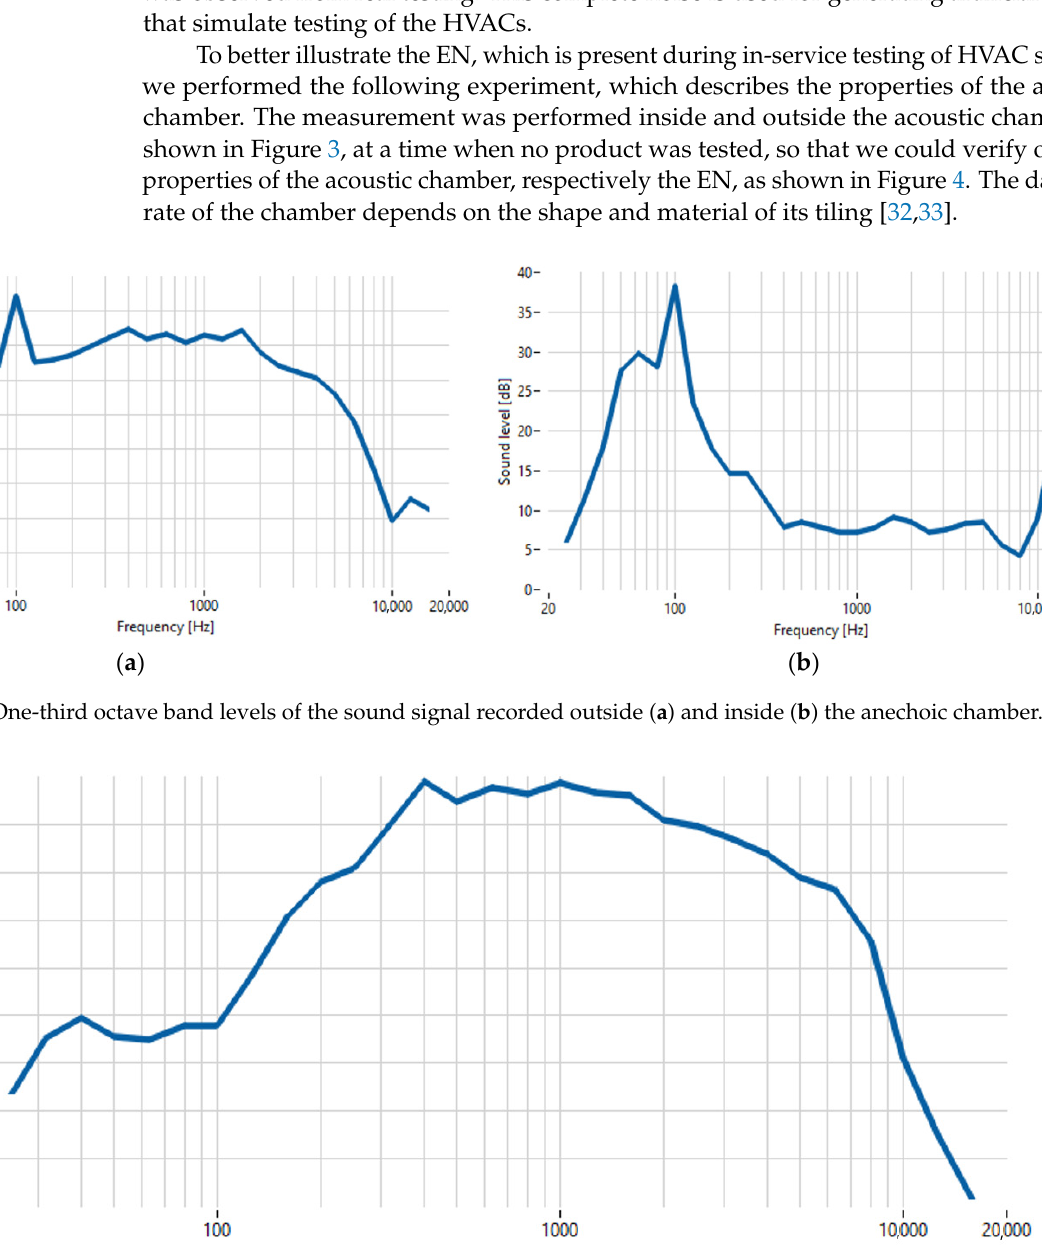
Figure 4. Absorption level of the anechoic chamber.